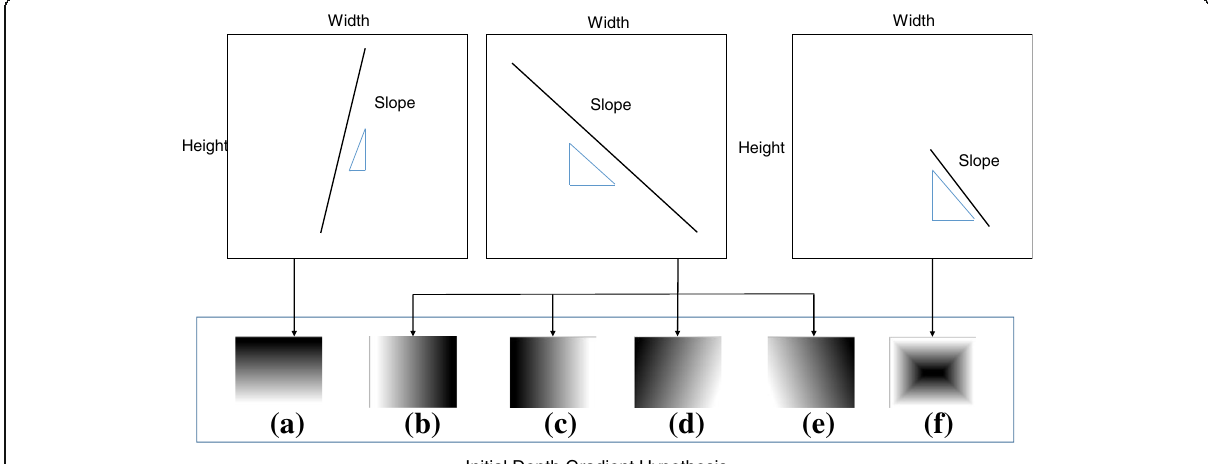
Fig. 7 Six kinds of initial depth gradient hypothesis